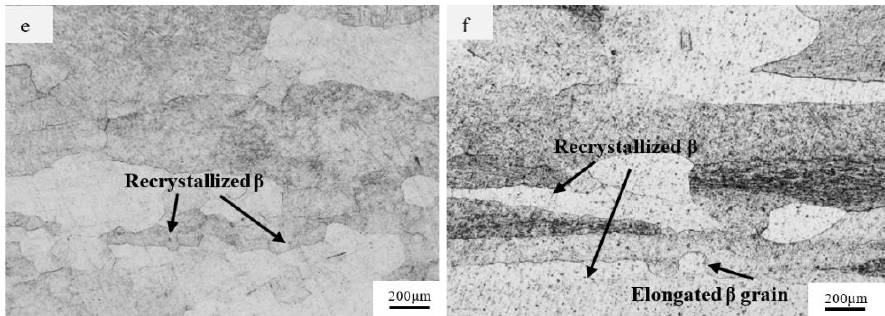
Fig. 10. Microstructure evolution of ATI425 alloy at various conditions in beta region: (a) 700°C and strain rate 0.001s -1 , (b) 700°C strain rate 0.01s -1 and (c) 800°C strain rate 0.1s -1 (c) 800°C strain rate 1s -1